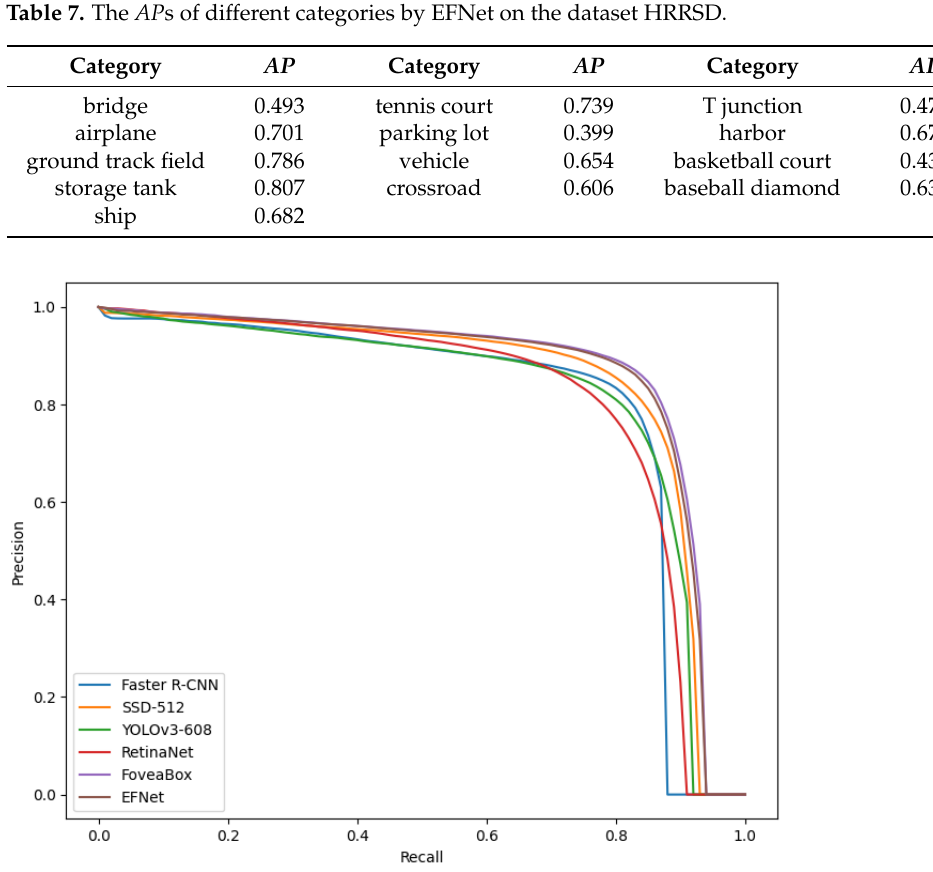
Figure 12. The PR curves of category building for comparative methods on AIBD. The AIBD contains only one building category. These curves are the different IoU s between predicted boxes and